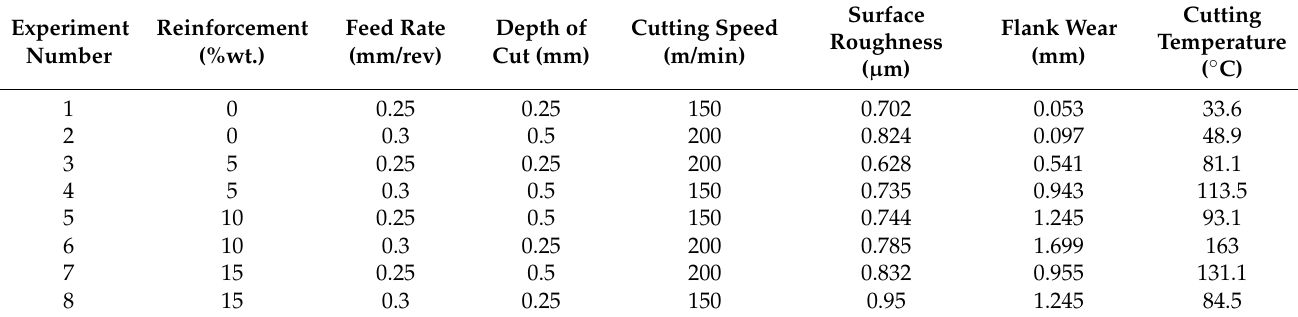
Table 3. Experimental results (Copyrights reserved)